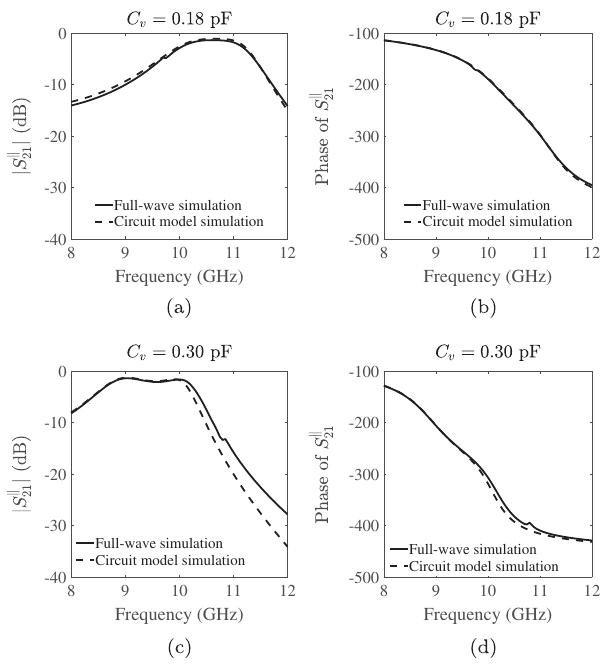
FIG. 19. Comparison between the full-wave simulation and the circuit model simulation of the birefringent board for the parallel